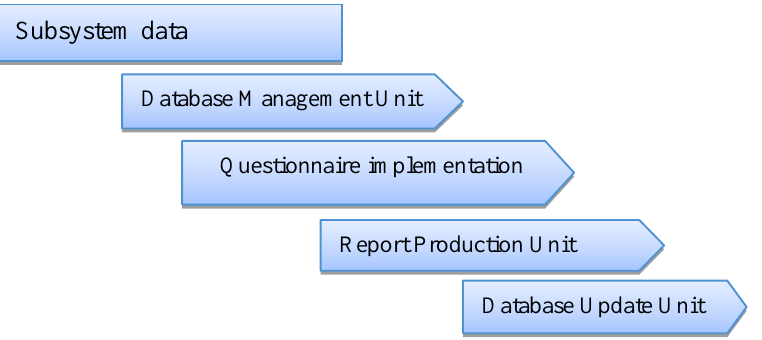
Figure 3. Data Management Subsystem